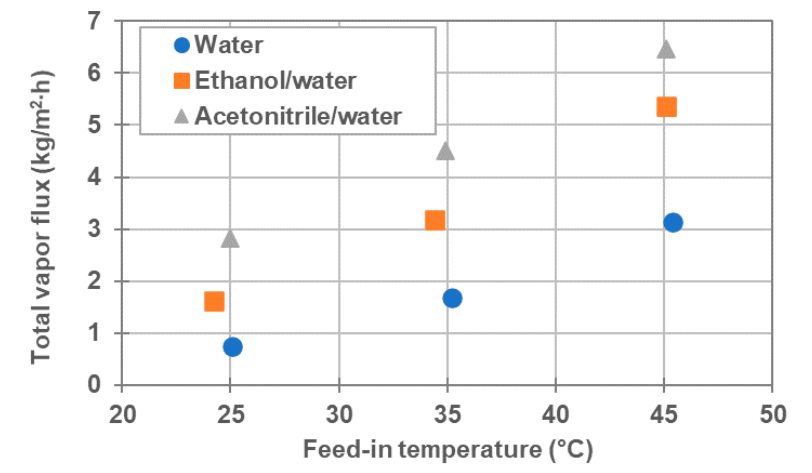
Figure 7. Total vapor flux for three kind of feeds, water (Table 2), ethanol/water and acetonitrile/wa-